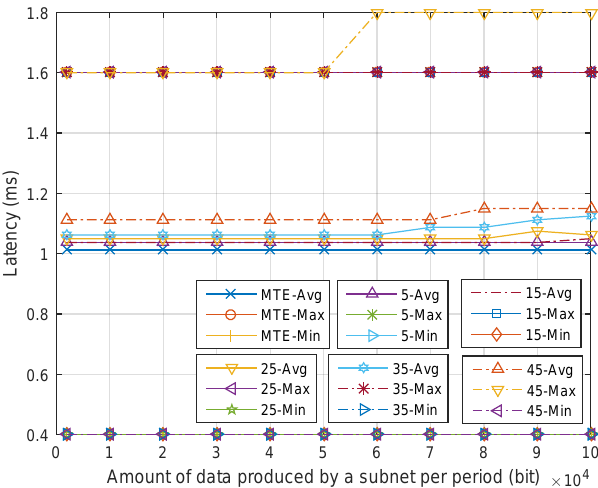
Figure 8. Latency with different network data load.